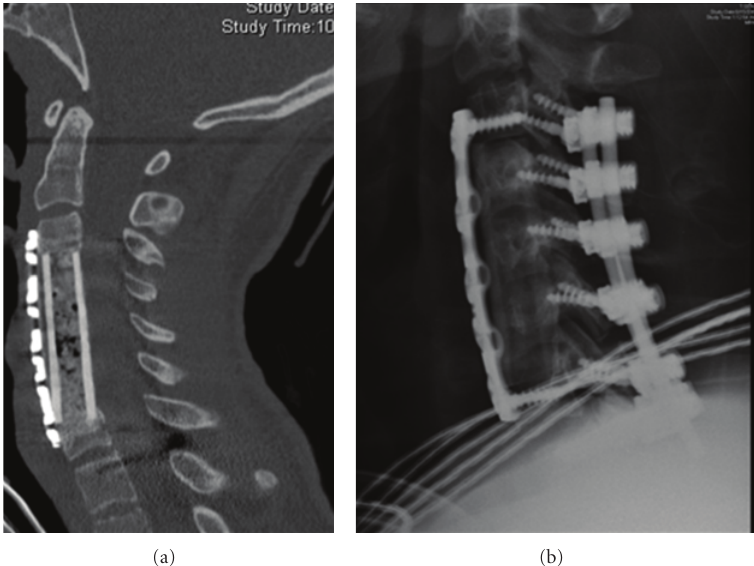
Figure 3: (a) Sagittal reconstructed CT scan of patient who underwent 3-level corpectomy. (b) Lateral radiograph of same patient. Posterior fusion was performed to increase stability of the